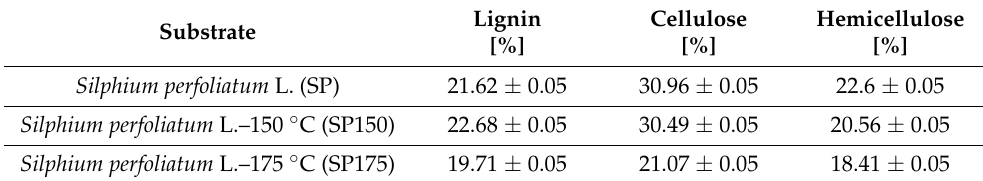
Table 8. The percentage of lignocellulosic compounds.